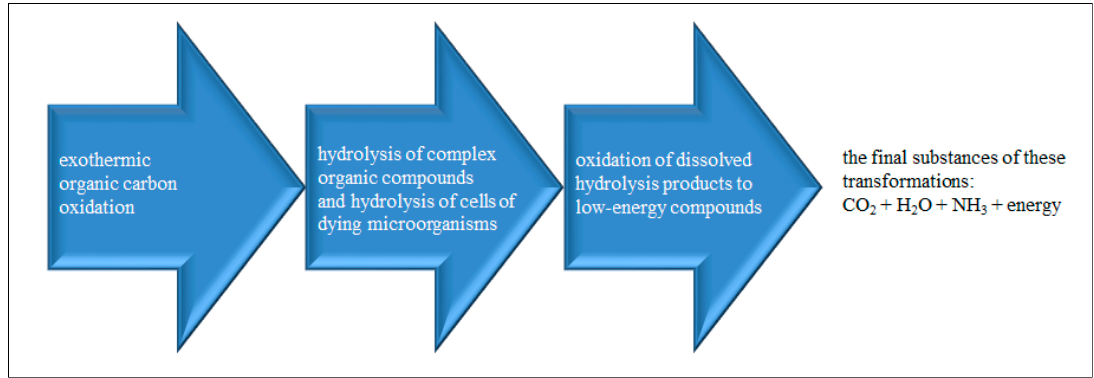
Figure 1. The autothermal process of thermophilic digestion.